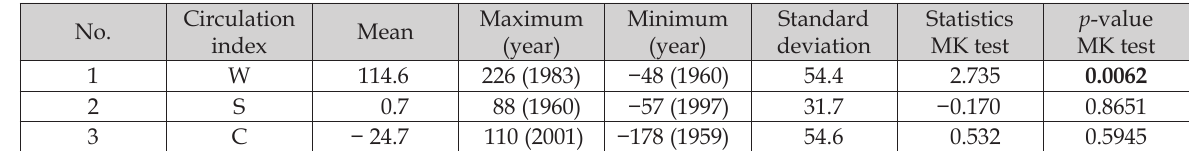
Fig. 3. The course of annual SSI on selected rivers: Drwęca (the highest mean multi-year flow), Wierzyca (average mean multi-year flow) and zgłowiączka (the lowest mean multi-year flow) in 1954–2018. SSI, Standardised Streamflow Table 2. Characteristics of annual atmospheric circulation indices: western zonal (W), southern meridional (S) and cyclonicity (C) in the analysed area and p -value of the MK test for the trend in 1954–2018 (hydrological year from November to October).